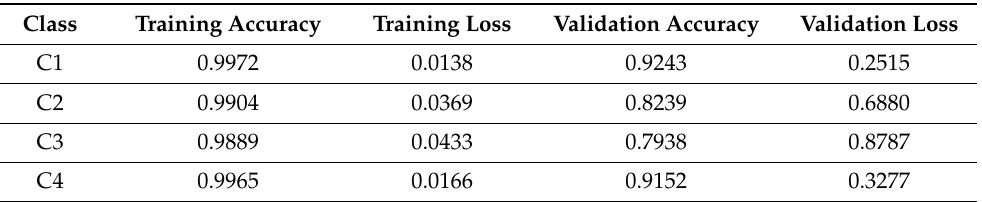
Table 2. The performance results of the proposed CNN solver model based on the conventional text-based CAPTCHA dataset.